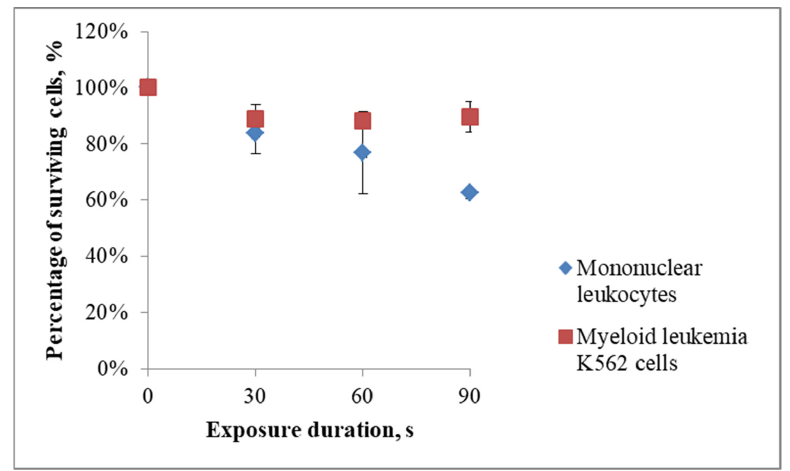
Figure 7. Dependence of the level of vitality of the healthy (blue diamonds) and tumor (red squares) cells on the time of processing by the direct piezodischarge of the physiological solution added to the nutritional medium. The cells were kept in the RPMI nutritional medium with the addition of 10% fetal bovine serum, amphotericin, and gentamycin, in a thermostat with increased CO 2 concentration (5%) at temperature of 37 °C. In detail, the experimental conditions are described in the Section 2. Apoptosis was recorded as the unique type of cell death in this experiment. At the same time, the results of the MTT test, which estimates the physiological activity of the cells, did not show a dependable difference of all points from the control. To construct the dependence shown in Figure 7, we only used the data obtained by the trypan blue dye, which shows cell vitality directly.